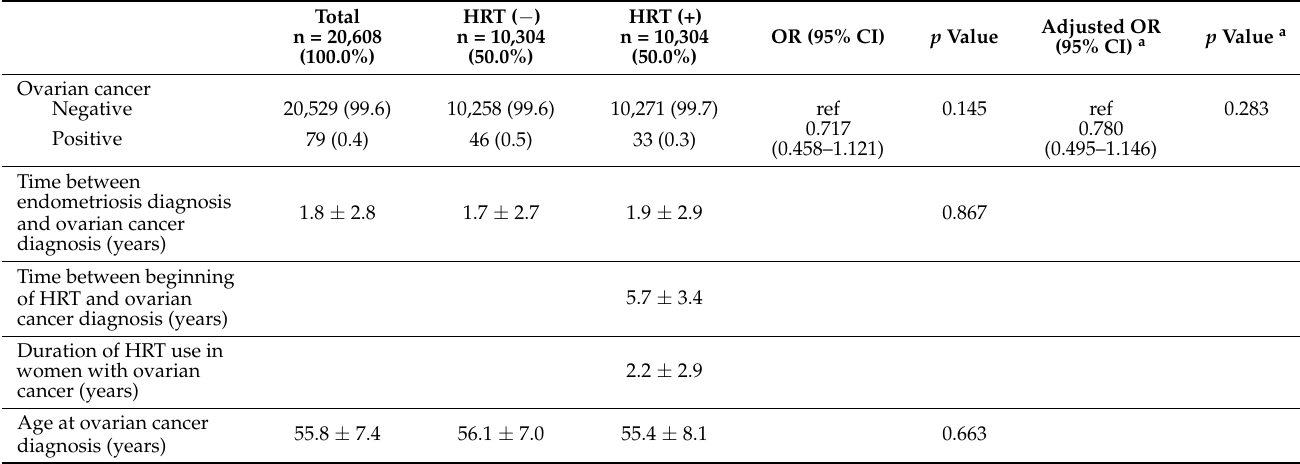
Table 2. Incidence and characteristics of ovarian cancer according to HRT in women with